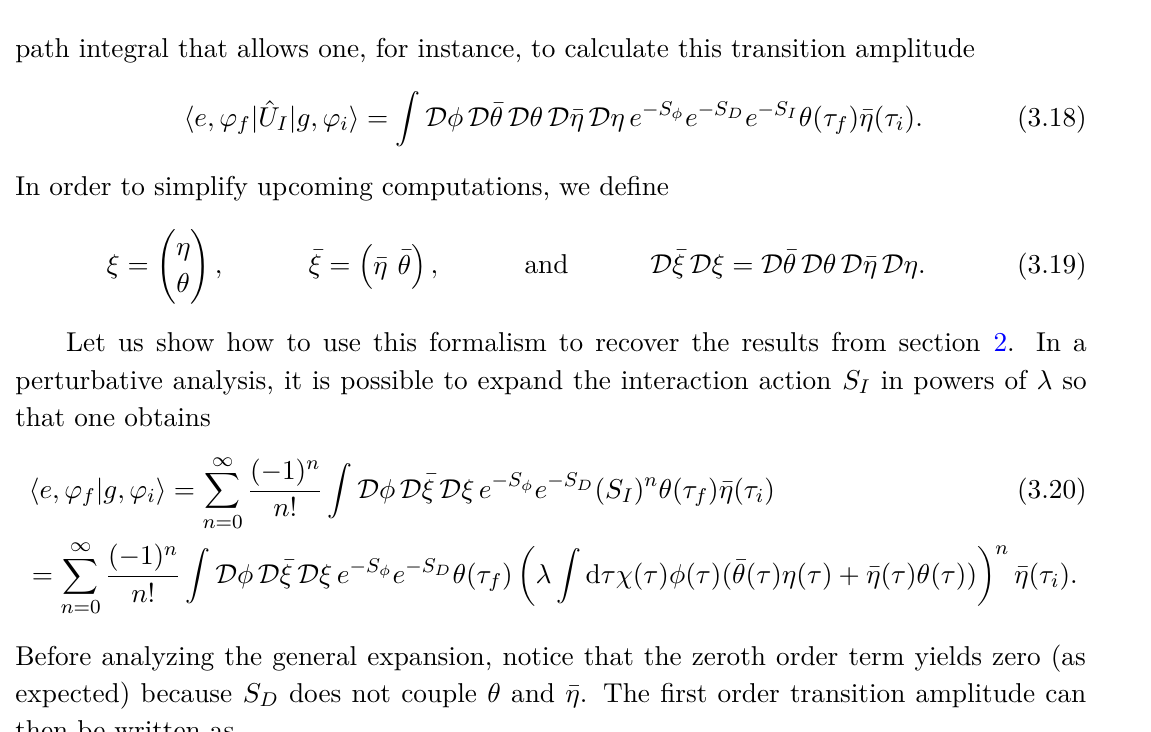
Figure 1 . Path integral for the excitation amplitude of the detector between two arbitrary field configurations at different Cauchy hypersurfaces. The region enclosed by these is denoted by M . Such a region defines a time evolution operator U ( M ) between the Cauchy